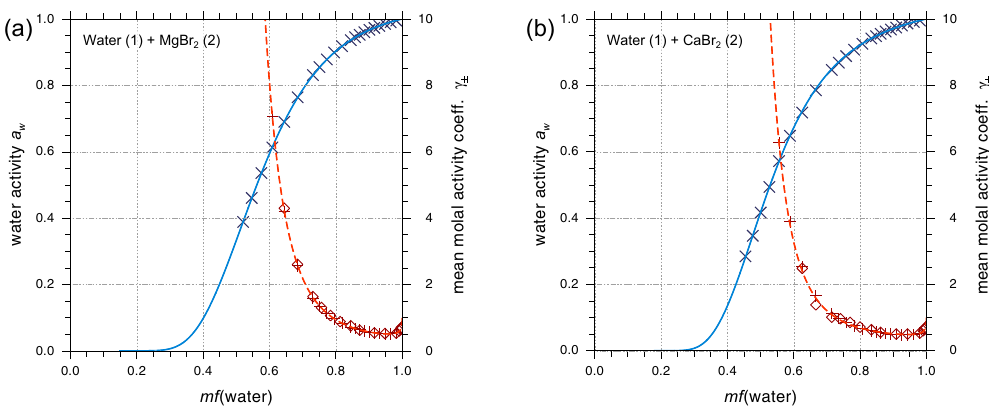
Fig. 9. Water activities and mean molal activity coefficients of the binary aqueous (a) MgBr 2 and (b) CaBr 2 systems at 298K. The curves show calculated water activities in blue and mean molal activity coefficients of the electrolytes in red (right y-axis), resulting from the AIOMFAC parameter fit to measurements (symbols), vs. mass fraction ( mf ) of water. Experimental data in (a) and (b) : a w ( ) and γ ± ( ) by Robinson and Stokes (2002), and γ ± ( ) by Zaytsev and Aseyev (1992).